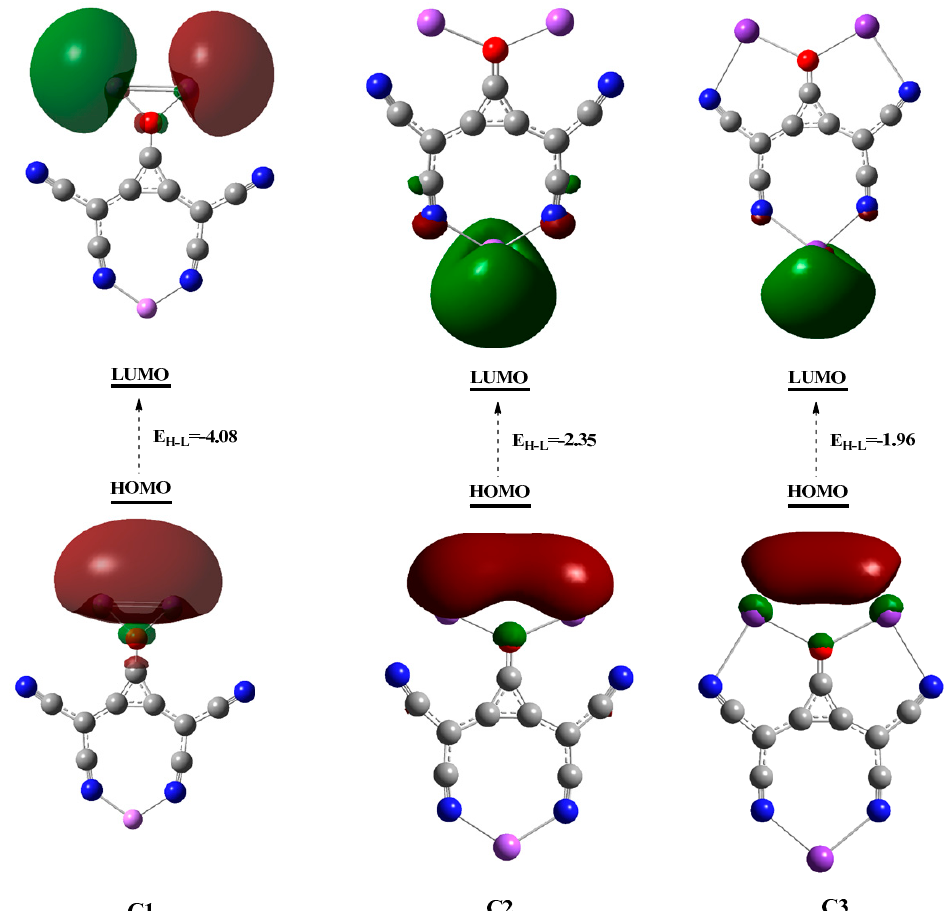
Figure 3. Generated HOMO and LUMO densities of clusters .